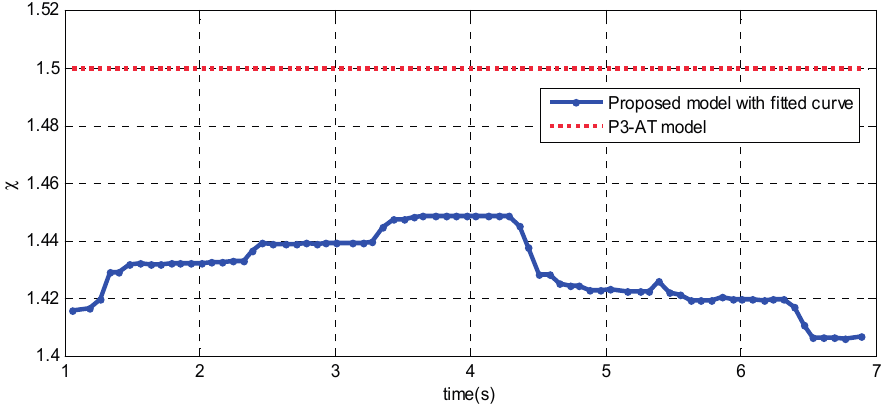
Figure 16. ICR coefficient χ using the proposed model and the P3-AT model for